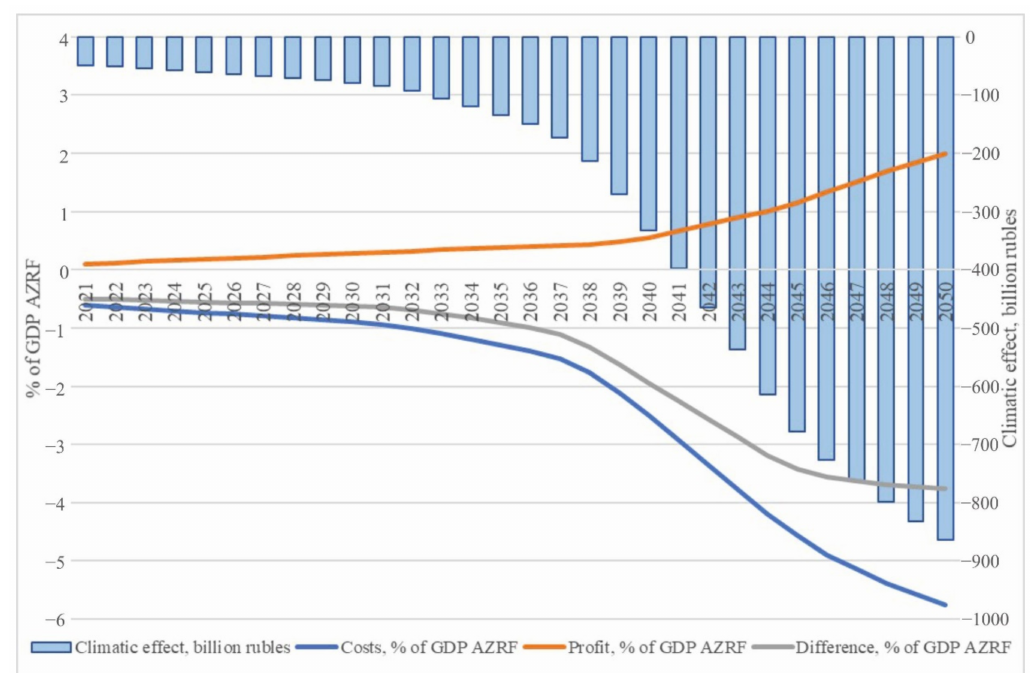
Figure 4. The forecast of the contribution of climatic dividends and costs to the GDP of the Russian Arctic (%) plotted against the total climatic effects for 2021–2050 (RUB